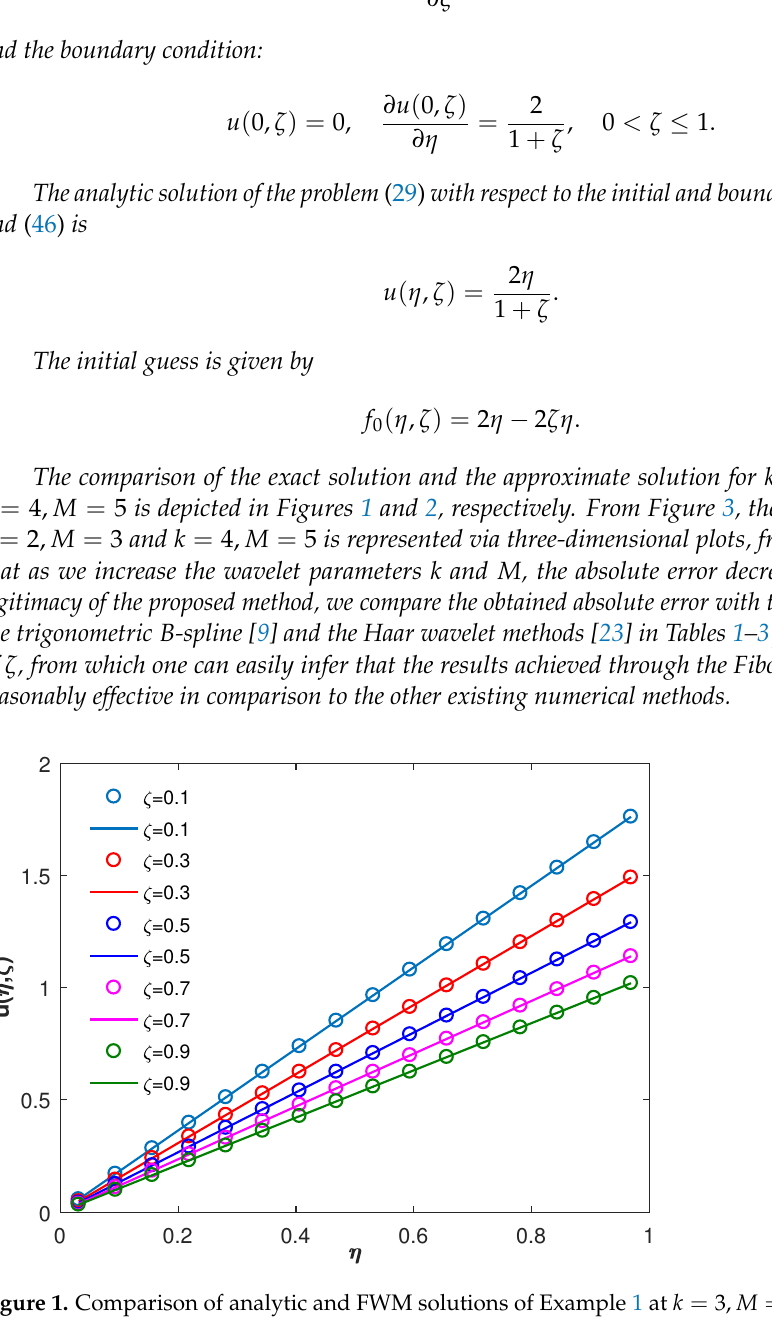
Figure 1. Comparison of analytic and FWM solutions of Example 1 at k = 3, M = 4 for different ζ